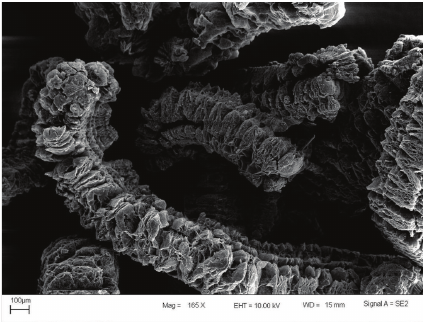
Figure 21: SEM micrograph of exfoliated graphite, residual after the Cone Calorimeter thermal